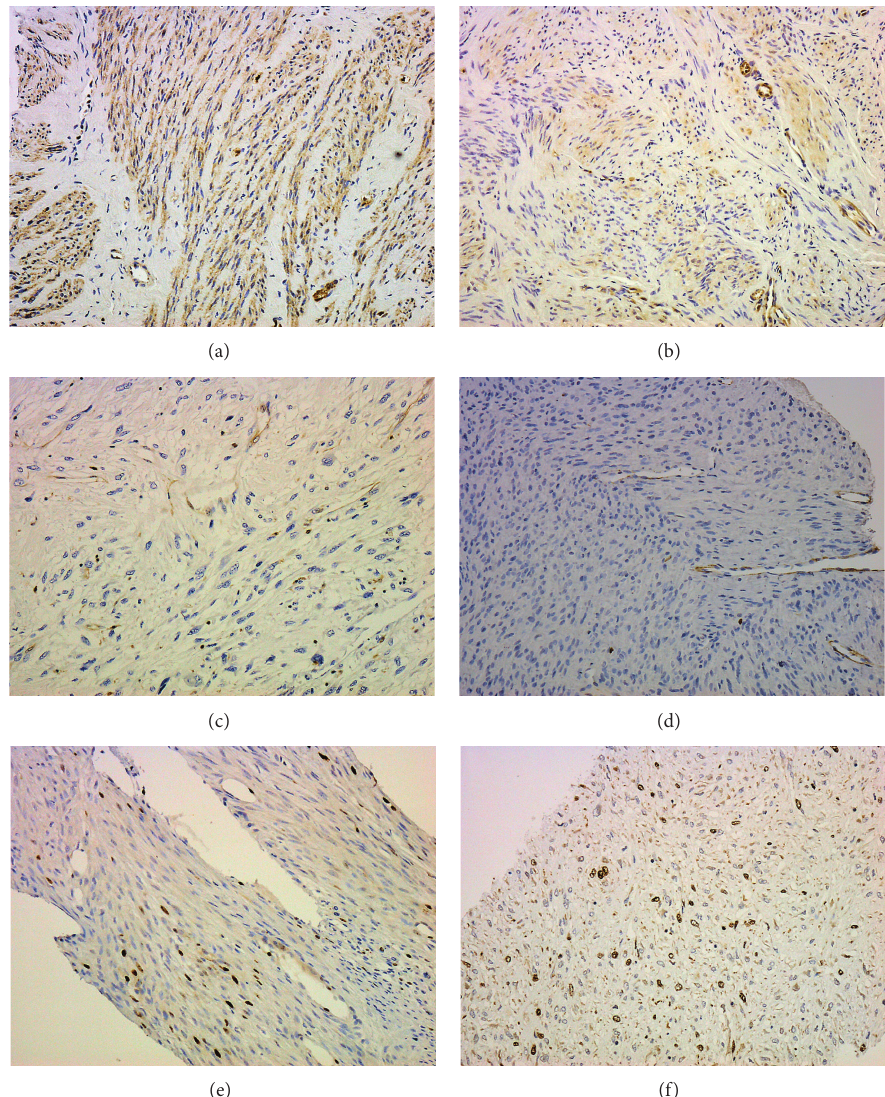
Figure 1: LMP2 and Ki-67 expression. (a) Positive expression of LMP2 in UL. (b) Weakly positive expression of LMP2 in UL. (c) Negative expression of LMP2 in LMS. (d) Ki-67 expression in UL (LI ≤ 5). (e) Ki-67 expression in UL (5 < LI < 15). (f) Ki-67 expression in LMS (LI ≥